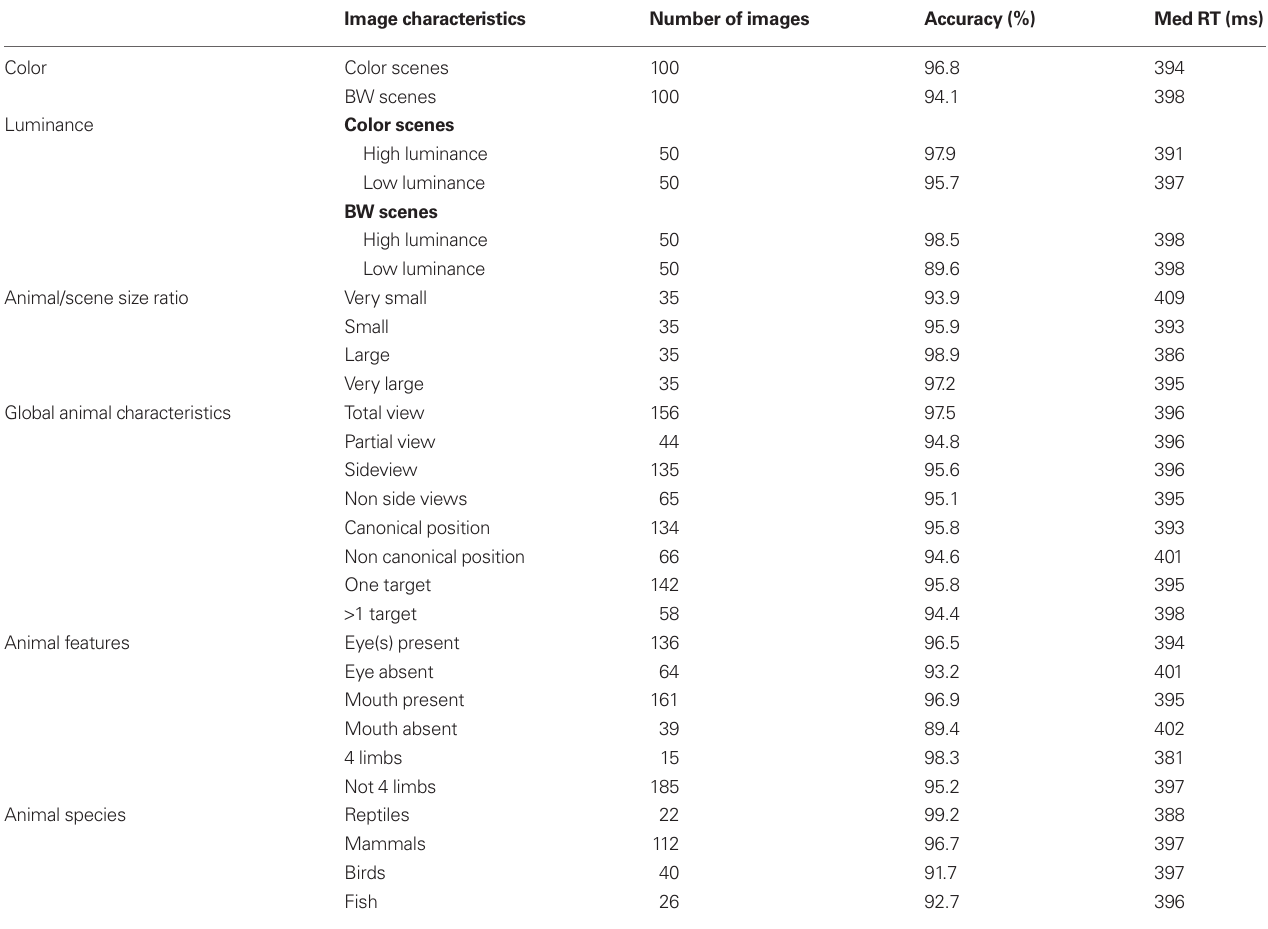
Table 1 | Number of photographs considered for the different image characteristics, along with the corresponding accuracy and median response